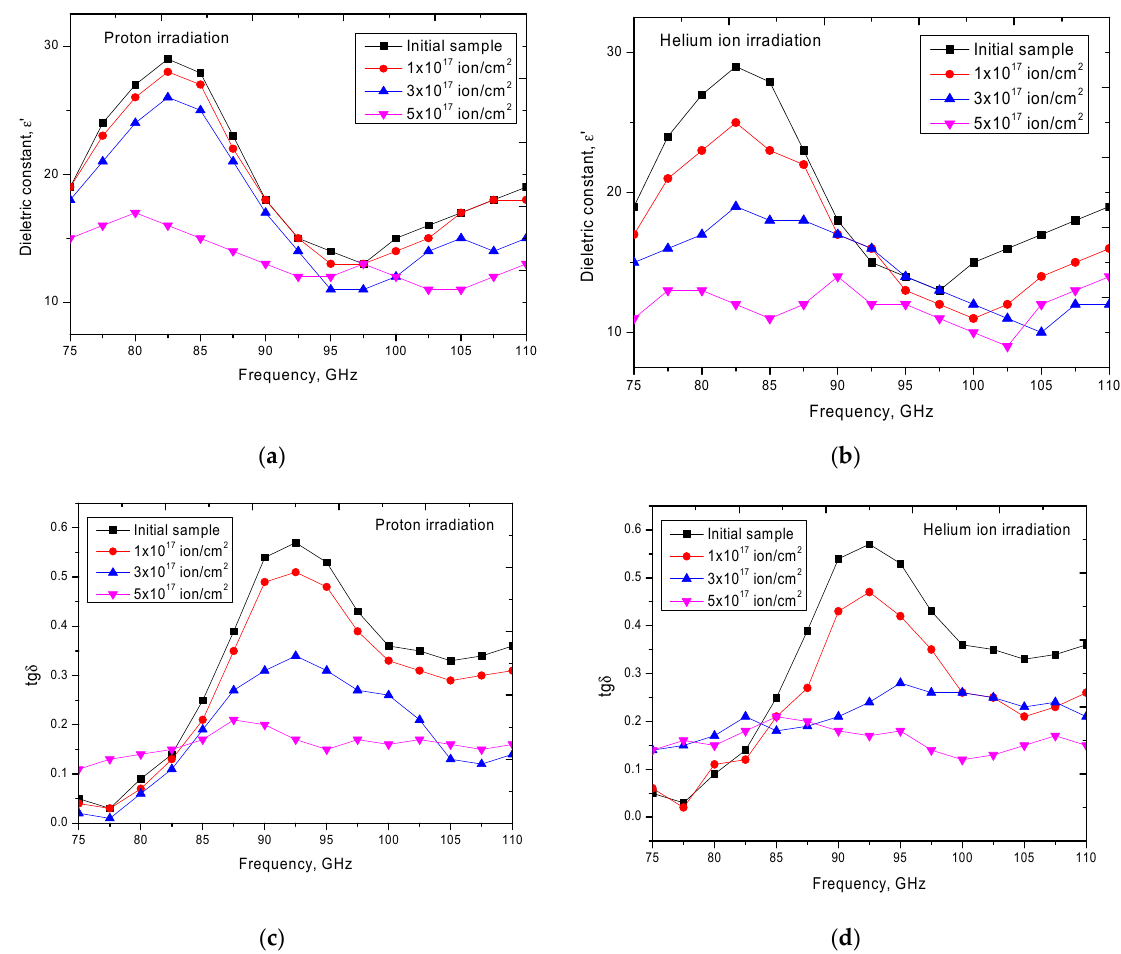
Figure 4. Graphs of the dependence of the dielectric constant on the type of exposure: ( a ) proton irradiation; ( b ) helium ion irradiation; and dielectric loss (tg δ ): ( c ) proton irradiation ( d ) helium ion